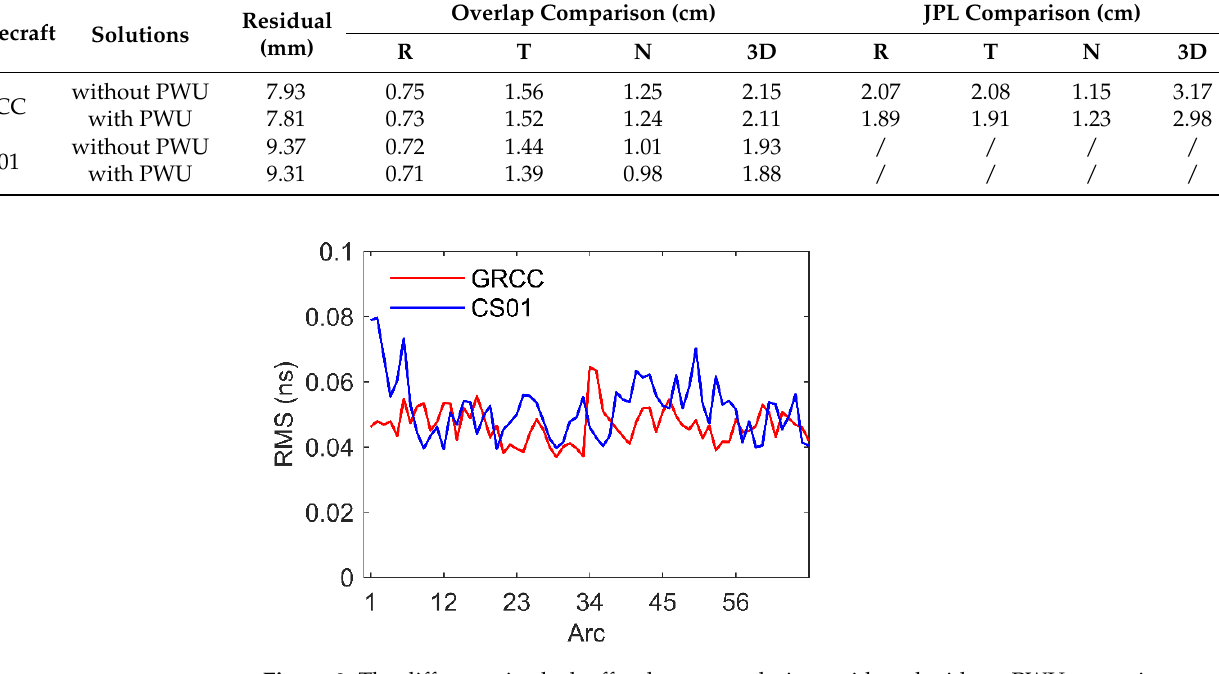
Figure 9. The difference in clock offset between solutions with and without PWU corrections.